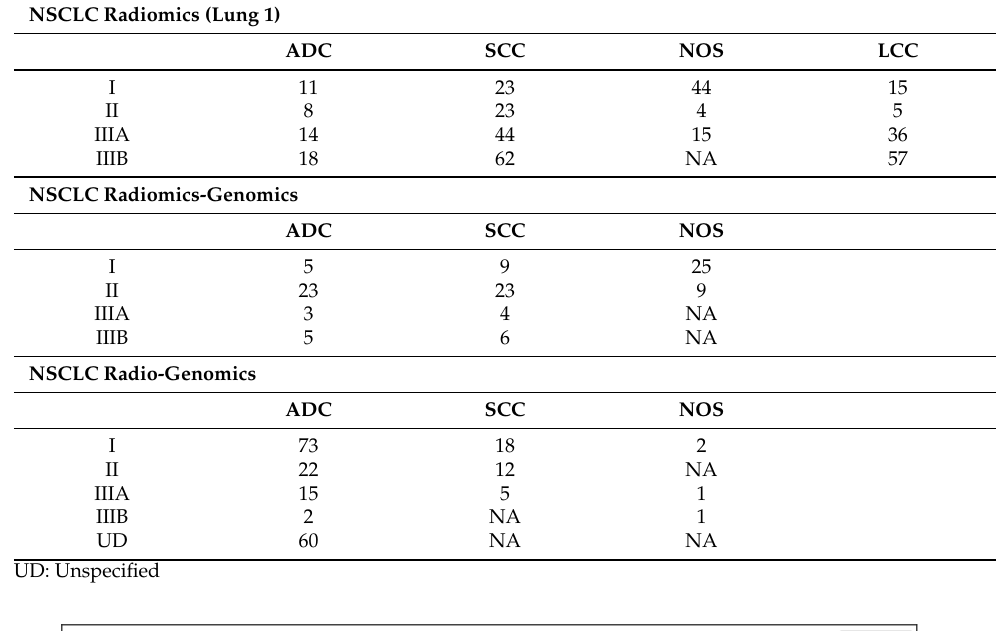
Table 1. Stage and Pathology (ADC, SCC, NOS and LCC) Distribution in the Non-Small Cell Lung Cancer Benchmark Datasets.